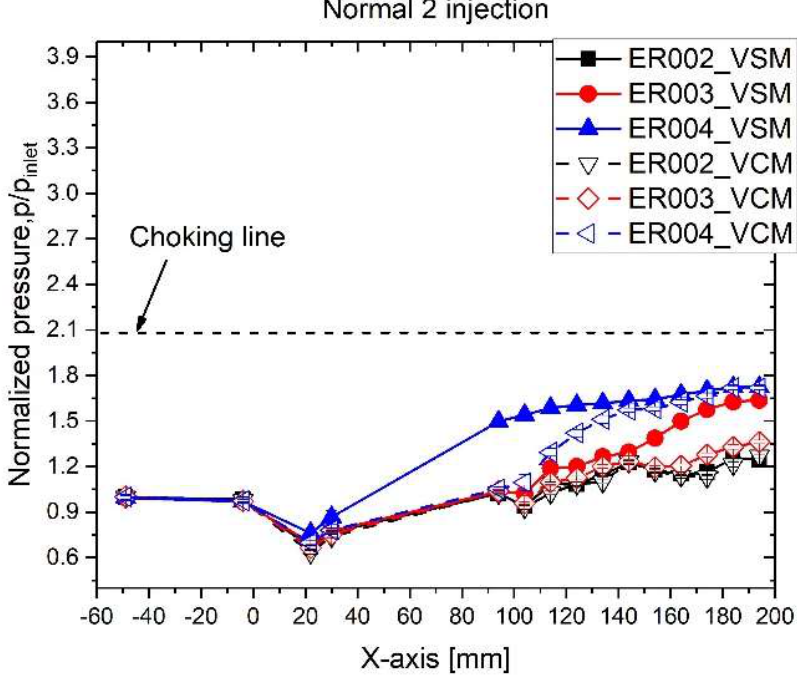
Figure 10. Flow structure transition of the normal 1 injection for ER rise: vent slot mixer ( a , c , e ) and vent circle mixer ( b , d , f ).